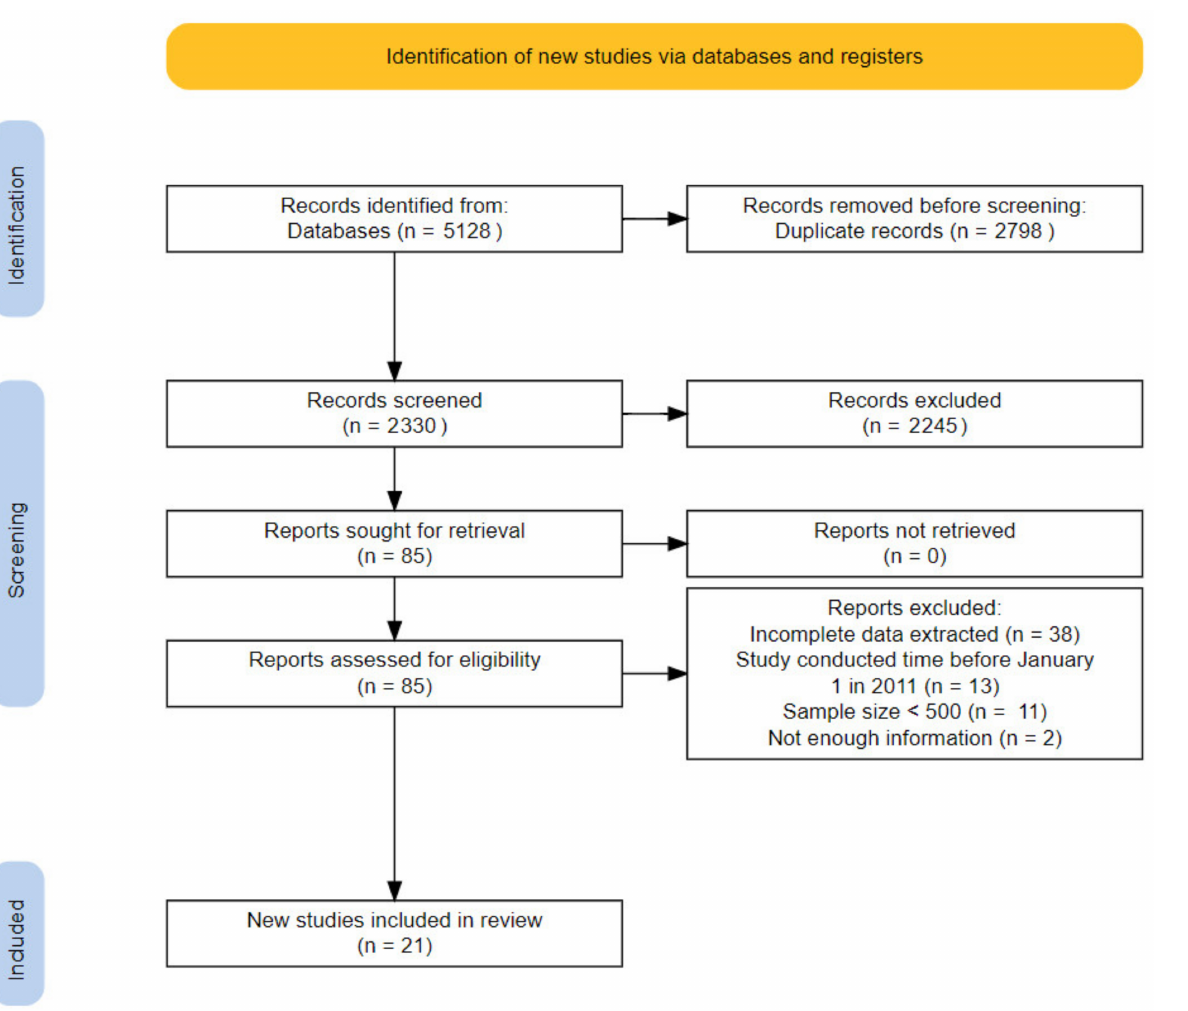
Figure 1. Flow diagram of the study selection